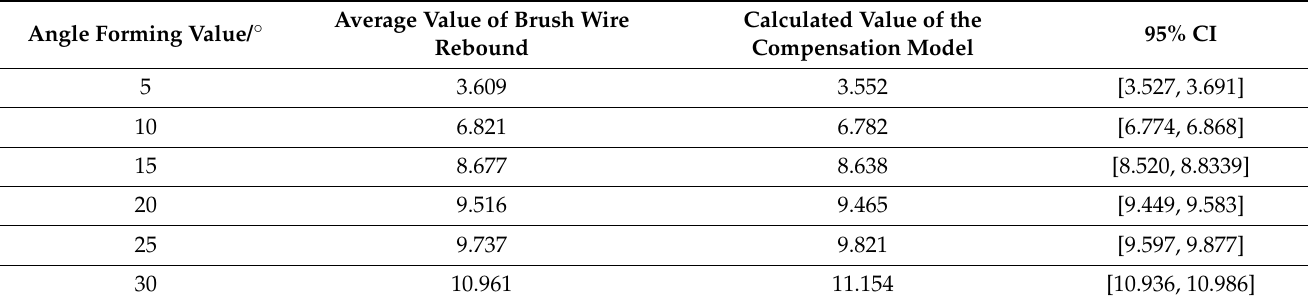
Table 4. Experimental results of the brush angle forming pre-compensation